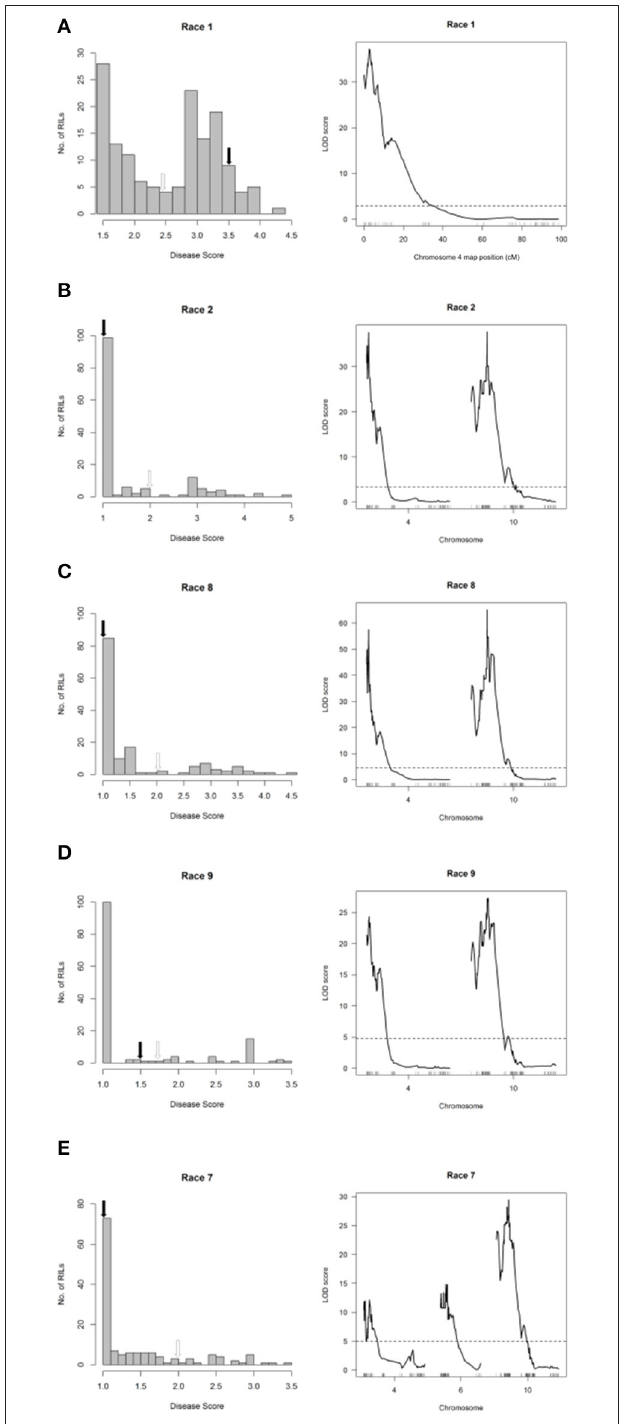
FIGURE 7 | Resistance mapping in the Phaseolus vulgaris Rojo × CAL 143 (RC) recombinant inbred population following separate inoculations with (A) Race 1, (B) Race 2, (C) Race 8, (D) Race 9, or (E) Race 7 of Pseudomonas syringae pv. phaseolicola detects QTL on Pv04, Pv10, and Pv06. (Left graphs) Distribution of interaction phenotypes exhibited by RC inbreds in glasshouse experiments. The phenotype scale ranges from highly